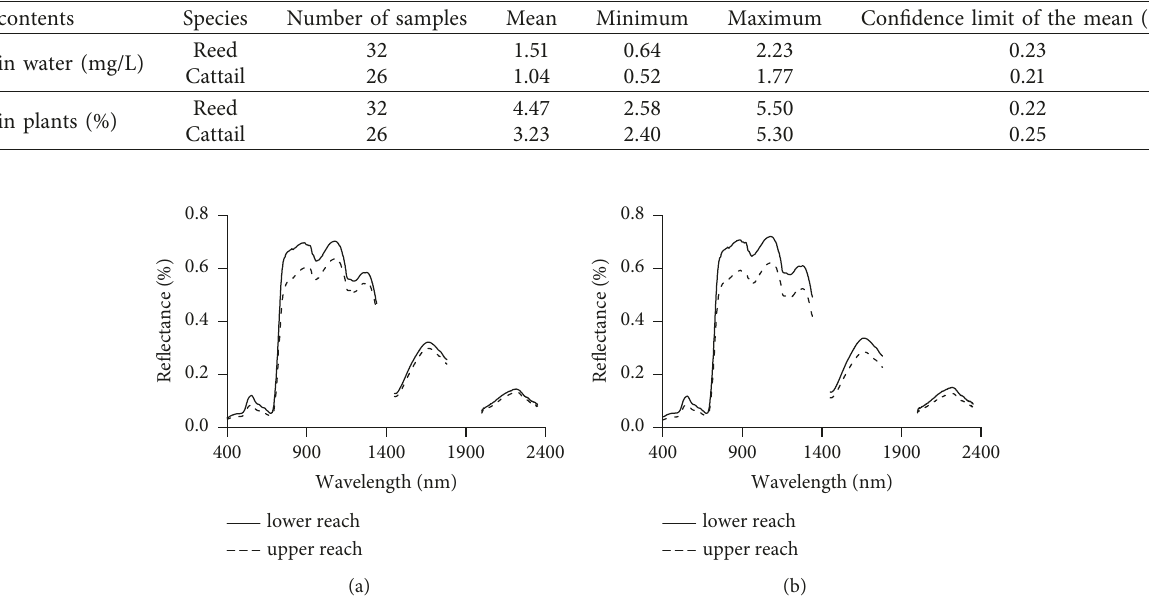
Figure 1: Reflectance of reeds (a) and cattails (b) at upper reach and lower reach of the Bai